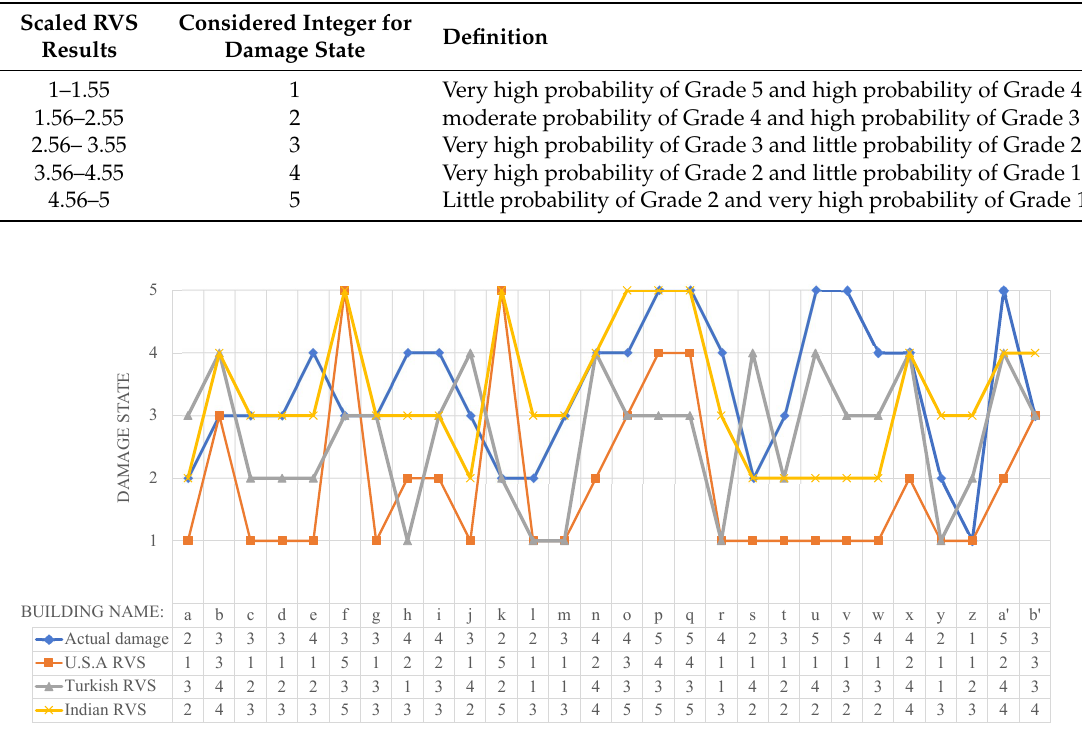
Figure 1. Damage state of selected building data from RVS